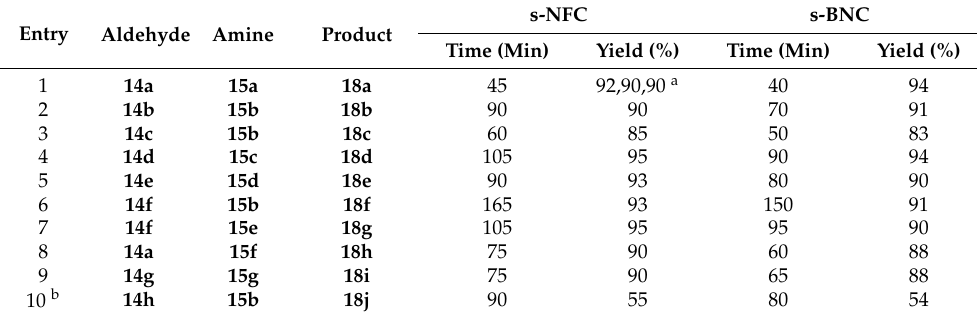
Table 2. Multicomponent reactions (MCR) for the synthesis of